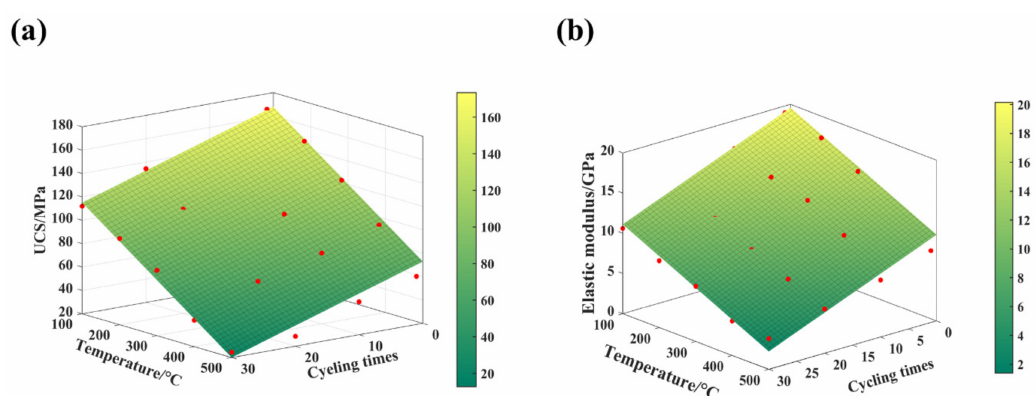
Figure 6. Variation of ( a ) UCS and ( b ) elastic modules with temperature and cycling